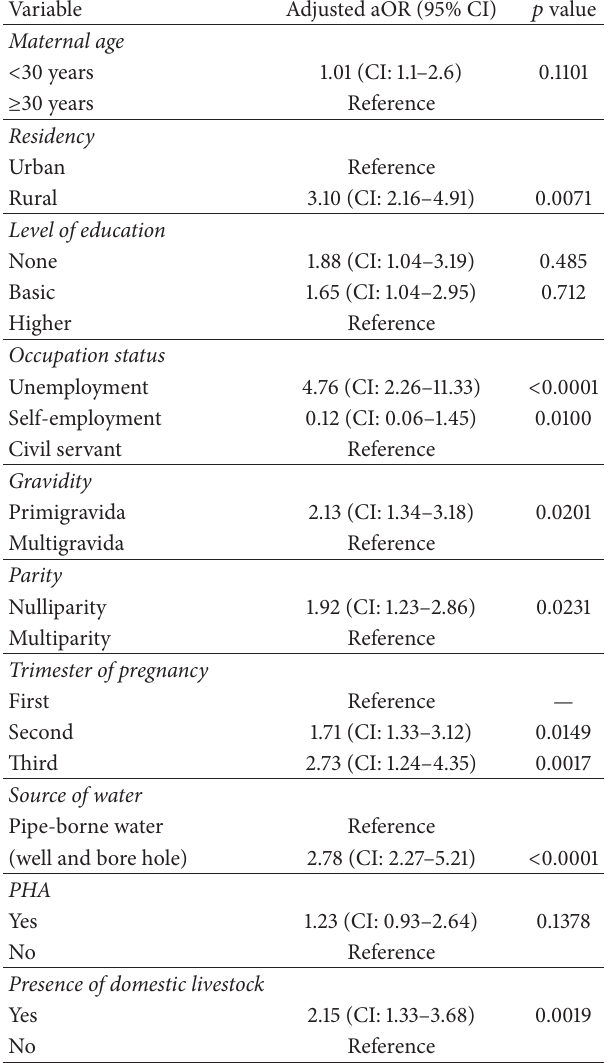
Table 4: Multivariate logistic regression of factors associated with anaemia in